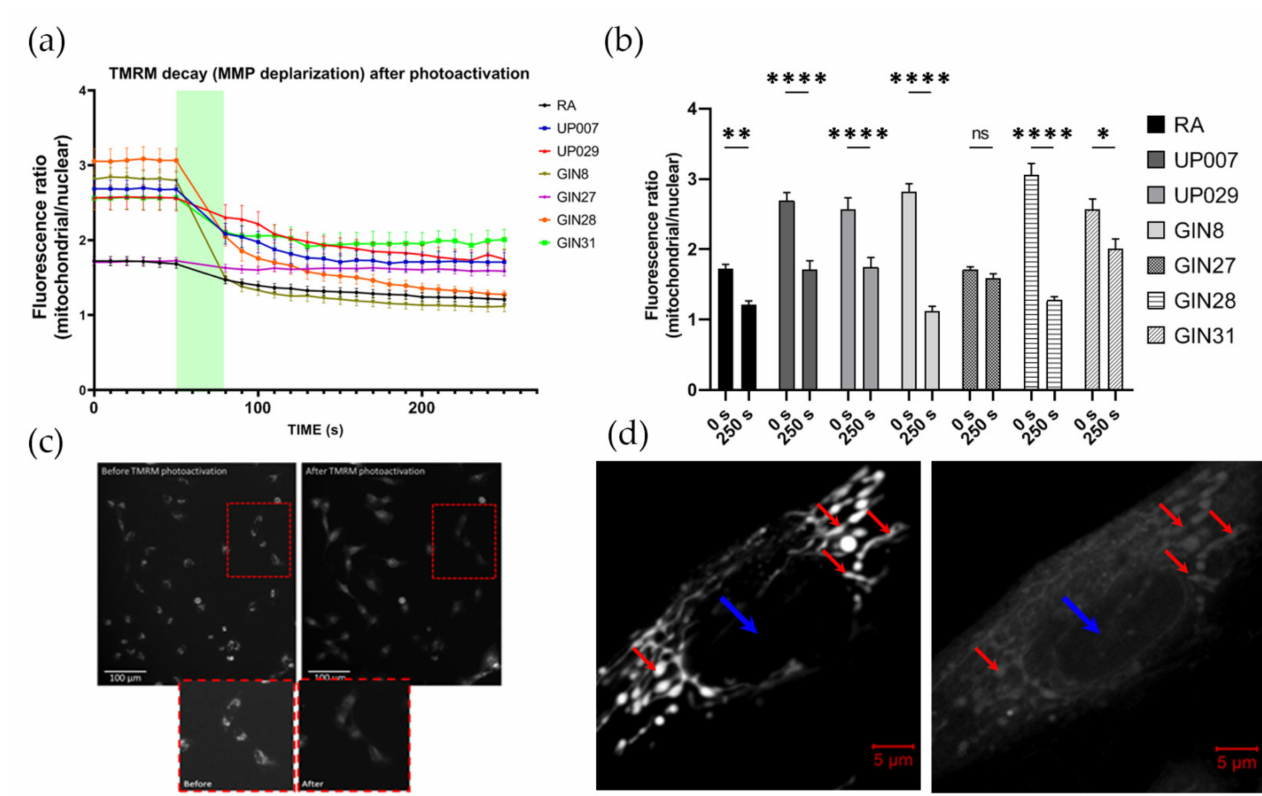
Figure 1. Light activation of TMRM triggers an immediate mitochondrial depolarization and results in dye re-distribution. ( a ) Mitochondria/nucleus fluorescence ratio dropped by 50% within 60 s and further decayed for the next 4–7 min. n: 24 cells from 4 independent exp. ( b ) Mitochondria/nucleus fluorescence ratios decreased after 250 s following light activation. ( c ) Representative images showing loss of TMRM from mitochondria over time and appearance of the dye in the nucleus. Red squares point to an enlarged area demonstrating a few cells at higher magnification (below). Note the redistribution of fluorescence from the bright clusters of mitochondria and its exit from the cells. The brightness of the images on the inset (lower images) is increased to facilitate viewing. For measurements, only raw images were used. ( d ) An example of a typical response to TMRM-PDT of a GBM GIN8 cell. Initially (left image), TMRM is localized exclusively to the mitochondria (red arrows) while the nucleus (blue arrow) is almost completely devoid of the staining. After photoactivation (right image), TMRM leaves the mitochondria and the contrast between mitochondria and nucleus is lost—hence the ratio mitochondria/nucleus drops). For clarification, images were taken at high magnification using LSM780 confocal microscope. (*) p value < 0.005, (**) p value < 0.001, (****) p value < 0.0001. ns—not